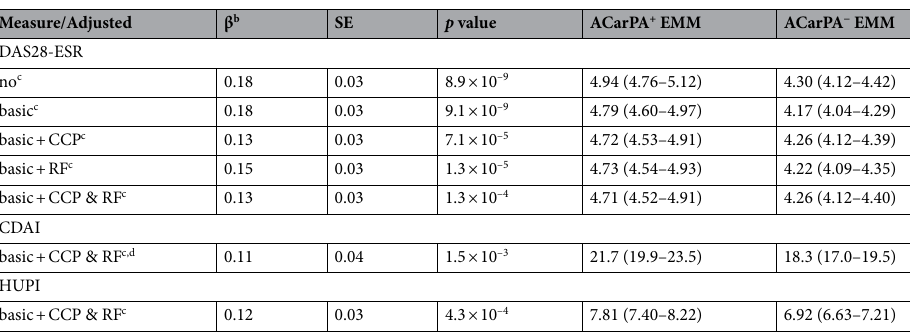
Table 2. Increased composite disease activity measures in the ACarPA + than in the ACarPA − patients at baseline a . a Data were available from 978 patients in the first-row analysis and 99% of them in the other DAS28- ESR analyses; from 902 patients in the CDAI analysis and from 974 patients in the HUPI analysis. b The slope coefficients (β) with their standard errors (SE) and p values and the estimated marginal means (EMM) with their 95% CI are presented. c The ACarPA + and ACarPA − EA patients were compared without adjustment or with the basic adjustment for sex, age, and the specific cohort (labeled “basic”), or with adjustment including also the presence of anti-CCP, RF, or both autoantibodies. d Similar results were obtained after transforming the CDAI values to conform with the normal distribution: β = 0.11, SE = 0.04, p = 2.1 × 10 –3 , ACarPA + EMM = 18.9